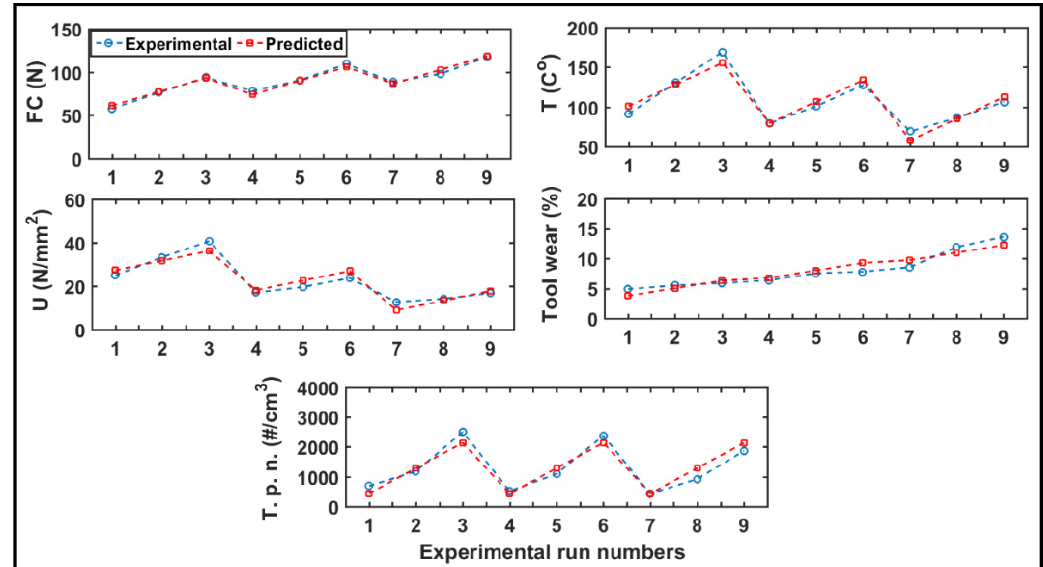
Figure 14. Comparison between experimental data and predicted data. Table 7. Comparison between experimental data and predicted data for the recommended spindle speed.